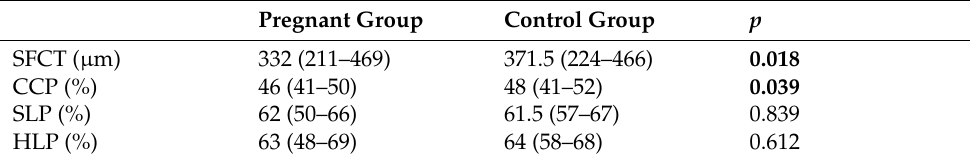
Table 2. Choroidal metrics.